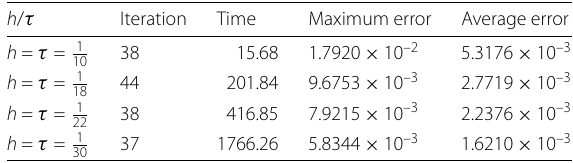
Table 11 The number of iterations, execution times (in sec) and errors of C–N high-order finite difference method for Test problem 2, when γ = 0.5 and ν =